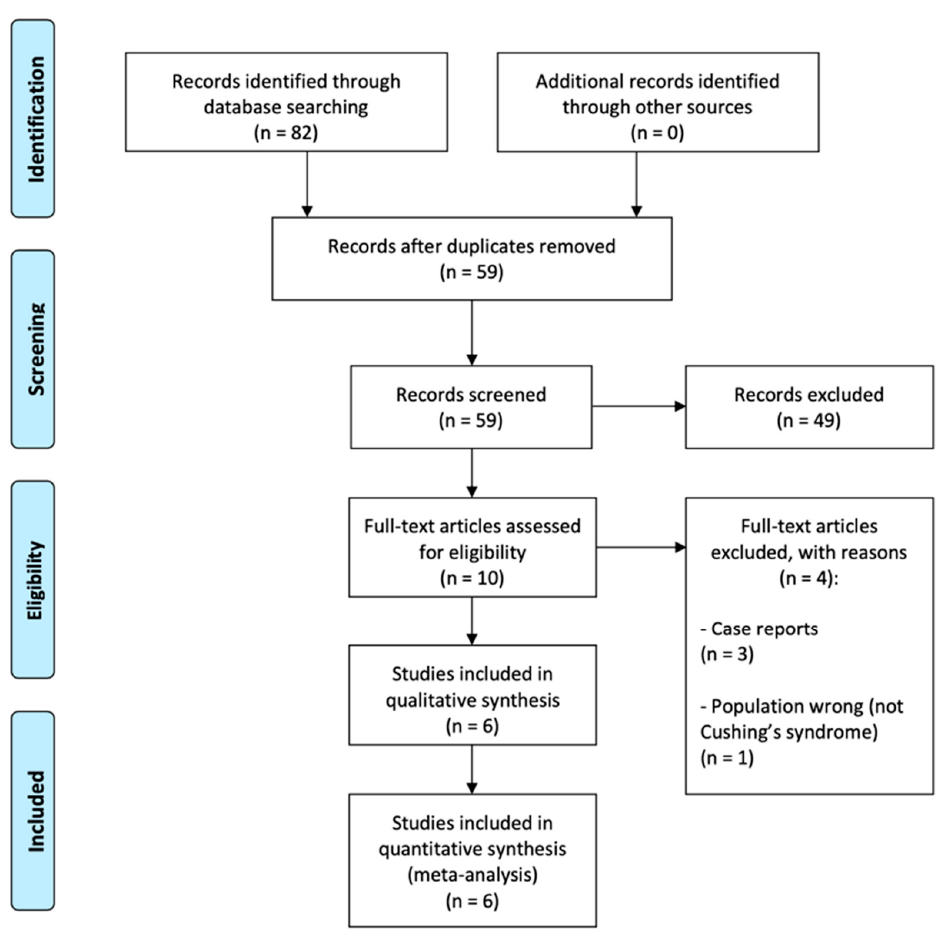
Figure 1. PRISMA flow diagram of study selection. Table 1. Study characteristics of eligible